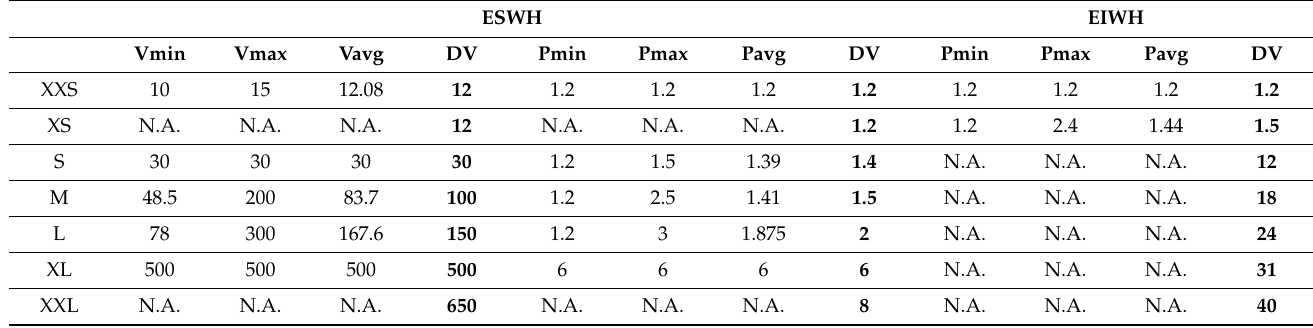
Table A4. Default values of volume and nominal capacity for electric water heaters.